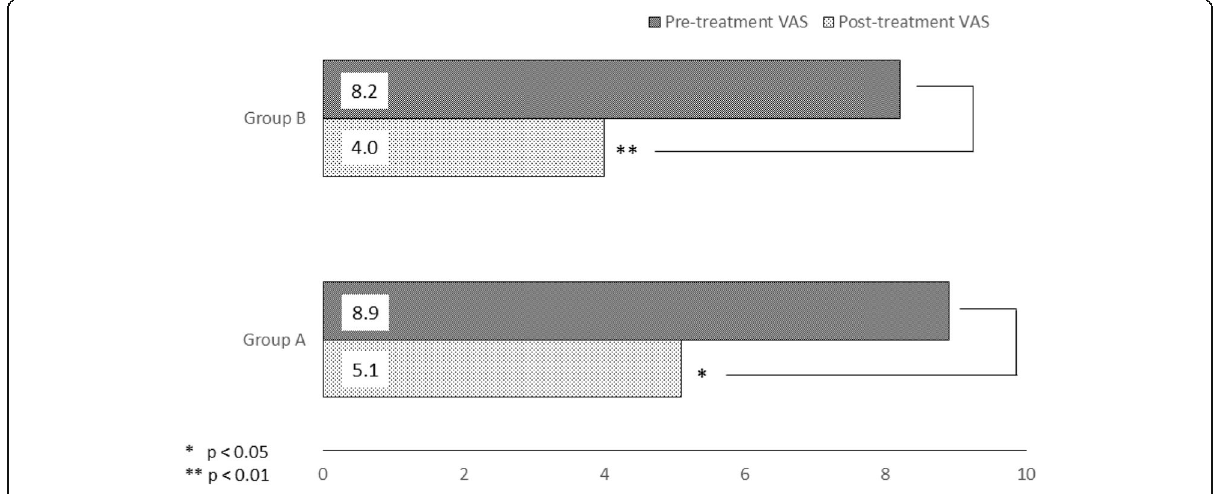
Fig. 1 Pre- and post-treatment VAS score for insulin-dependent (group A) and non-insulin-dependent patients (group B)